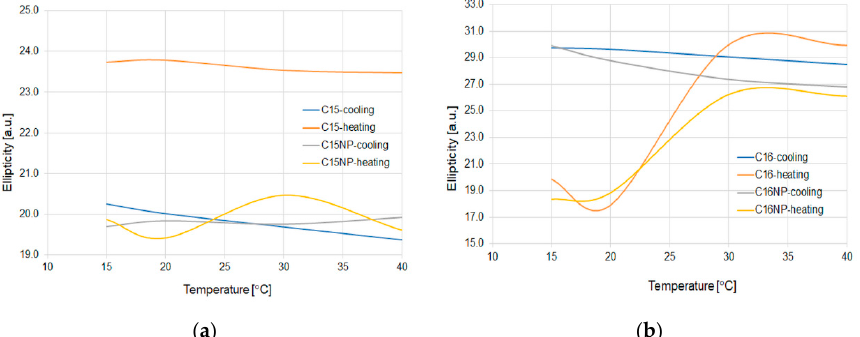
Figure 13. Fluctuation of ellipticity for C15 ( a ) and C16 ( b ) for pure and with NP mixture at 15–40 °C for all microdevices.